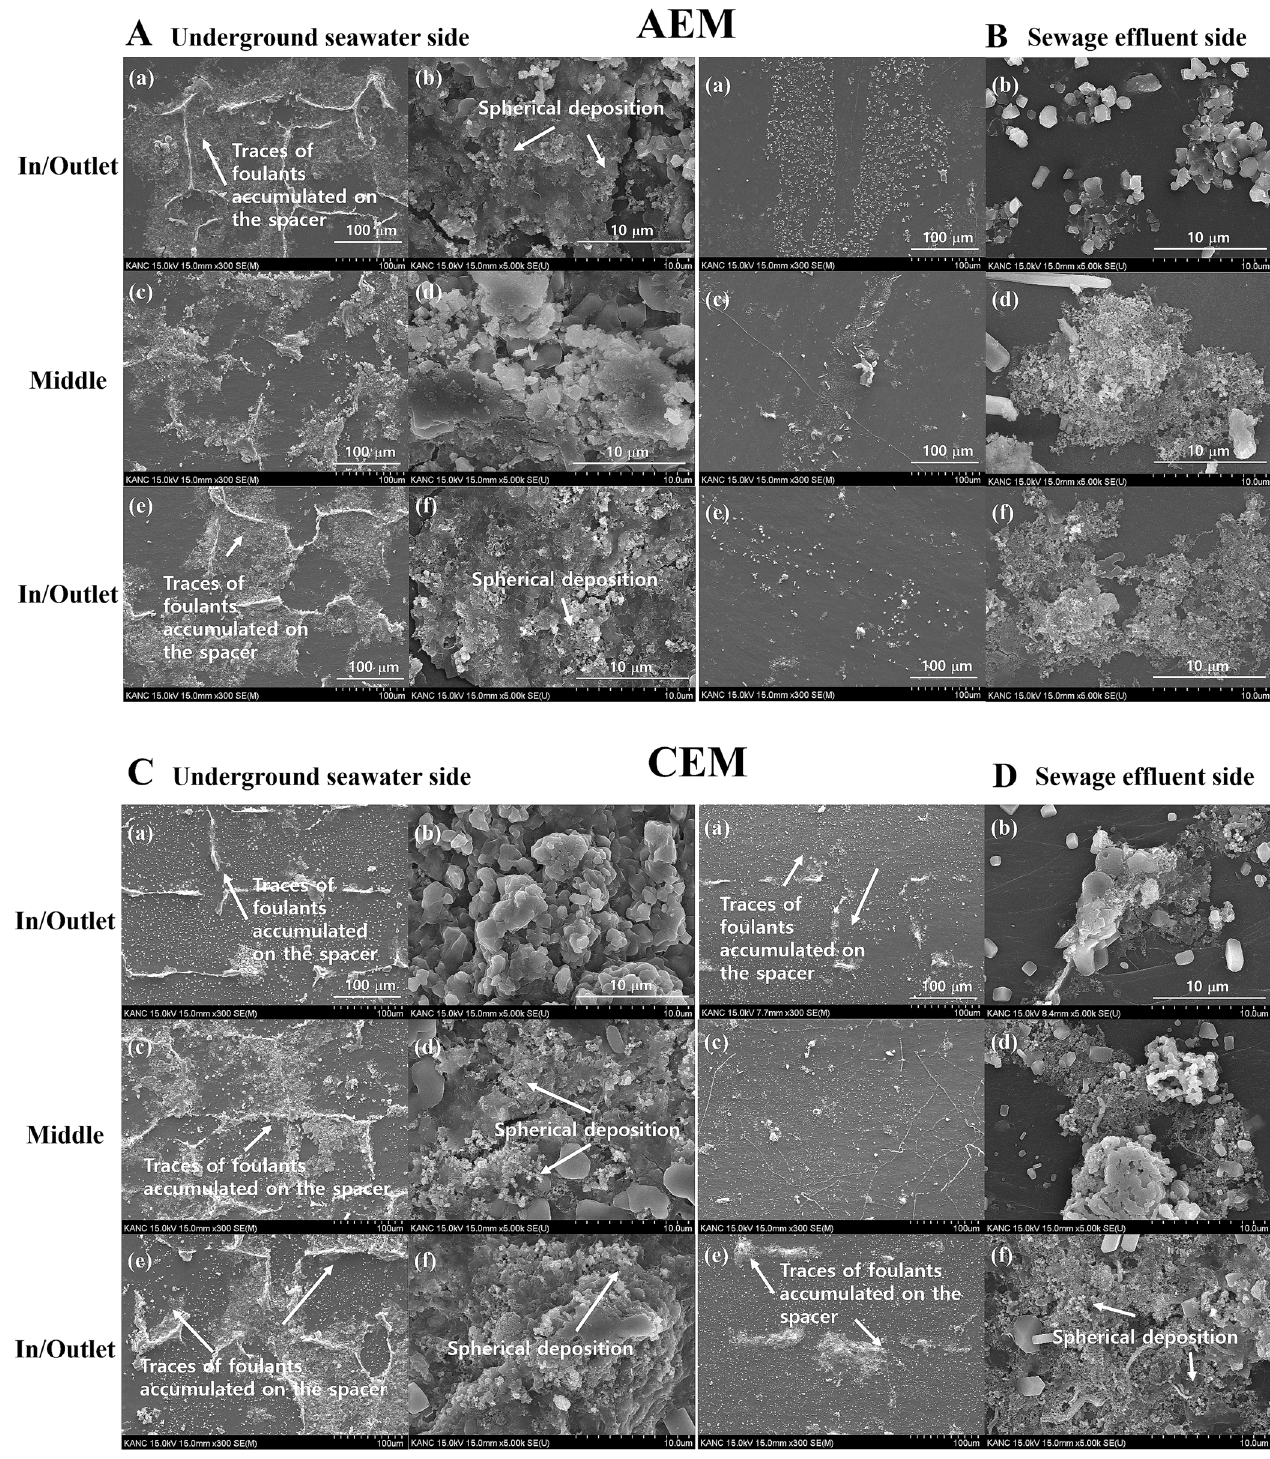
Fig. 5 FE-SEM images of the fl at membranes after continuous RED operation for 5 days. A , B Show FE-SEM images of AEM at the underground seawater side and at the sewage ef fl uent side. C, D Show FE-SEM images of CEM at the underground seawater side and at the sewage ef fl uent side. Image magni fi cations: (a), (c), and (e) 300×; (b), (d), and (f) deposition, caused by particulate/colloidal foulants, occurred on the surface of the membranes in contact with underground seawater. Furthermore, particulate matter in natural waters, including a wide size range of colloids, forms a caked layer by accumulating after the initial blocking of pores 30 . Although the